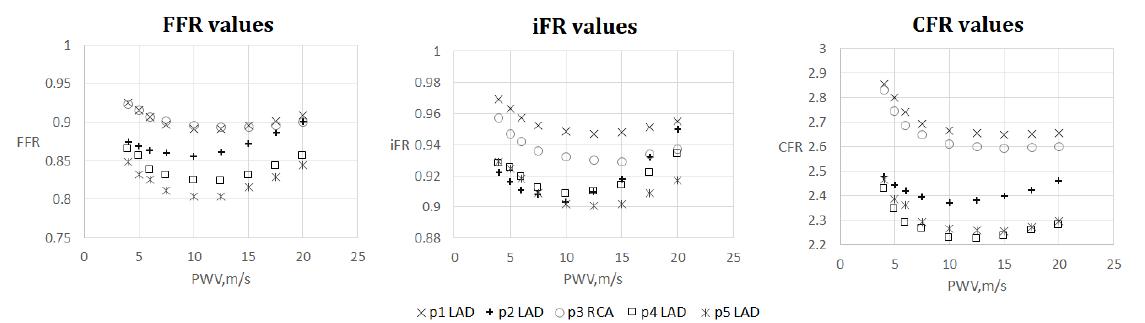
Figure 4. FFR, iFR and CFR sensitivity to AoPWV for patients from 1 to 5.